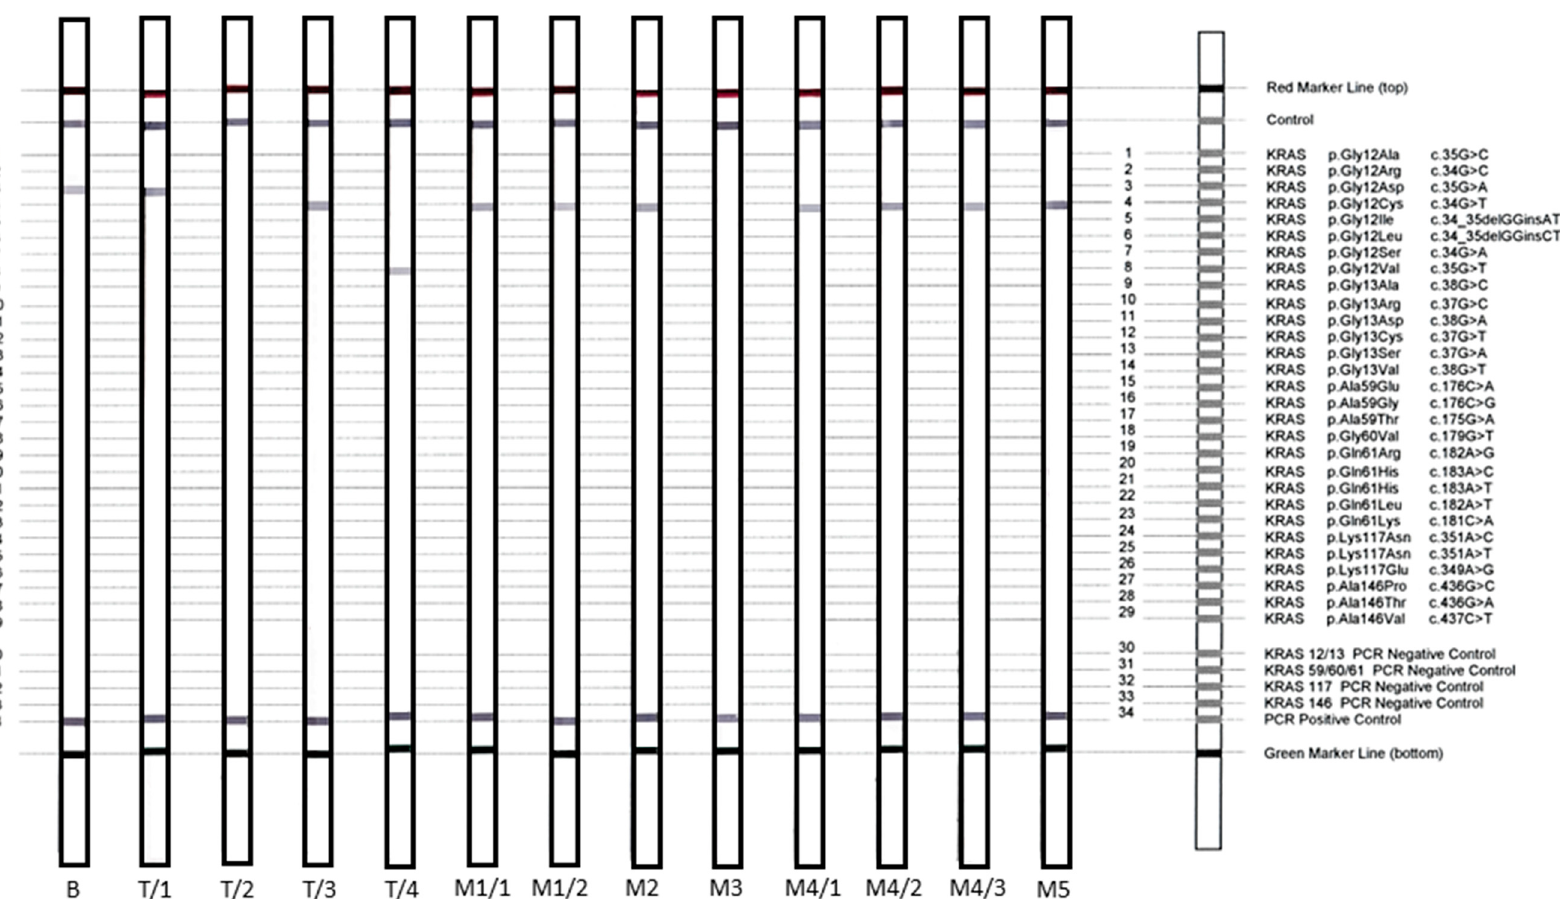
Figure 2. The results of a KRAS reverse-hybridization strip assay visually presenting KRAS variants as specific hybridization bands on individual membrane strips processed for all tumor samples. The adjustment of the strips to the deciphering template enables the exact determination of gene variants. Altogether, three types of codon 12 KRAS variants (T/1, T/3, T/4) and wild-type KRAS (T/2) were identified at the time of the primary surgery. Variant c.34G > T; p.Gly12Cys, originally present only in primary T/3, could be followed during the complete disease course, except for in sample M3 (solitary liver metastasis at month 18 from primary surgery).